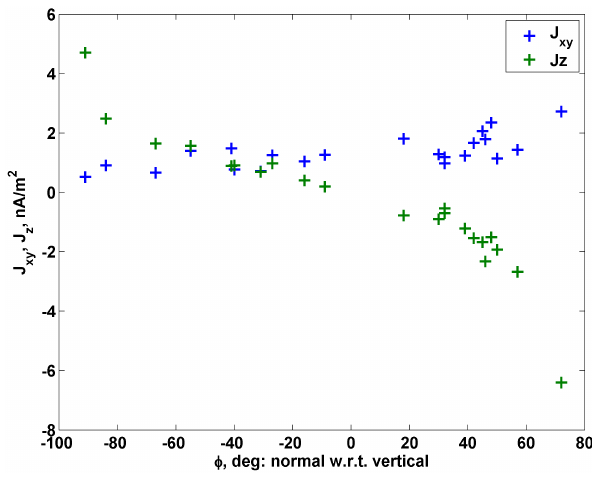
q J 2 x + J 2 y and J z current density components relative Fig. 7. J xy = to tilts for all individual crossings in Fig. 2.